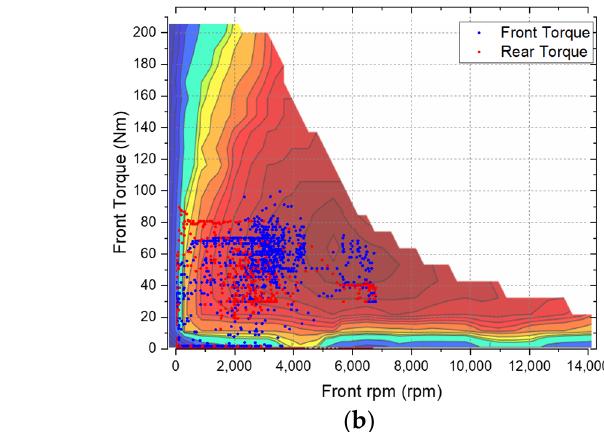
Figure 10. DER of load environment: UDDS, 10% grade and 240 kg load ( a ) 4WD, ( b ) TMS.